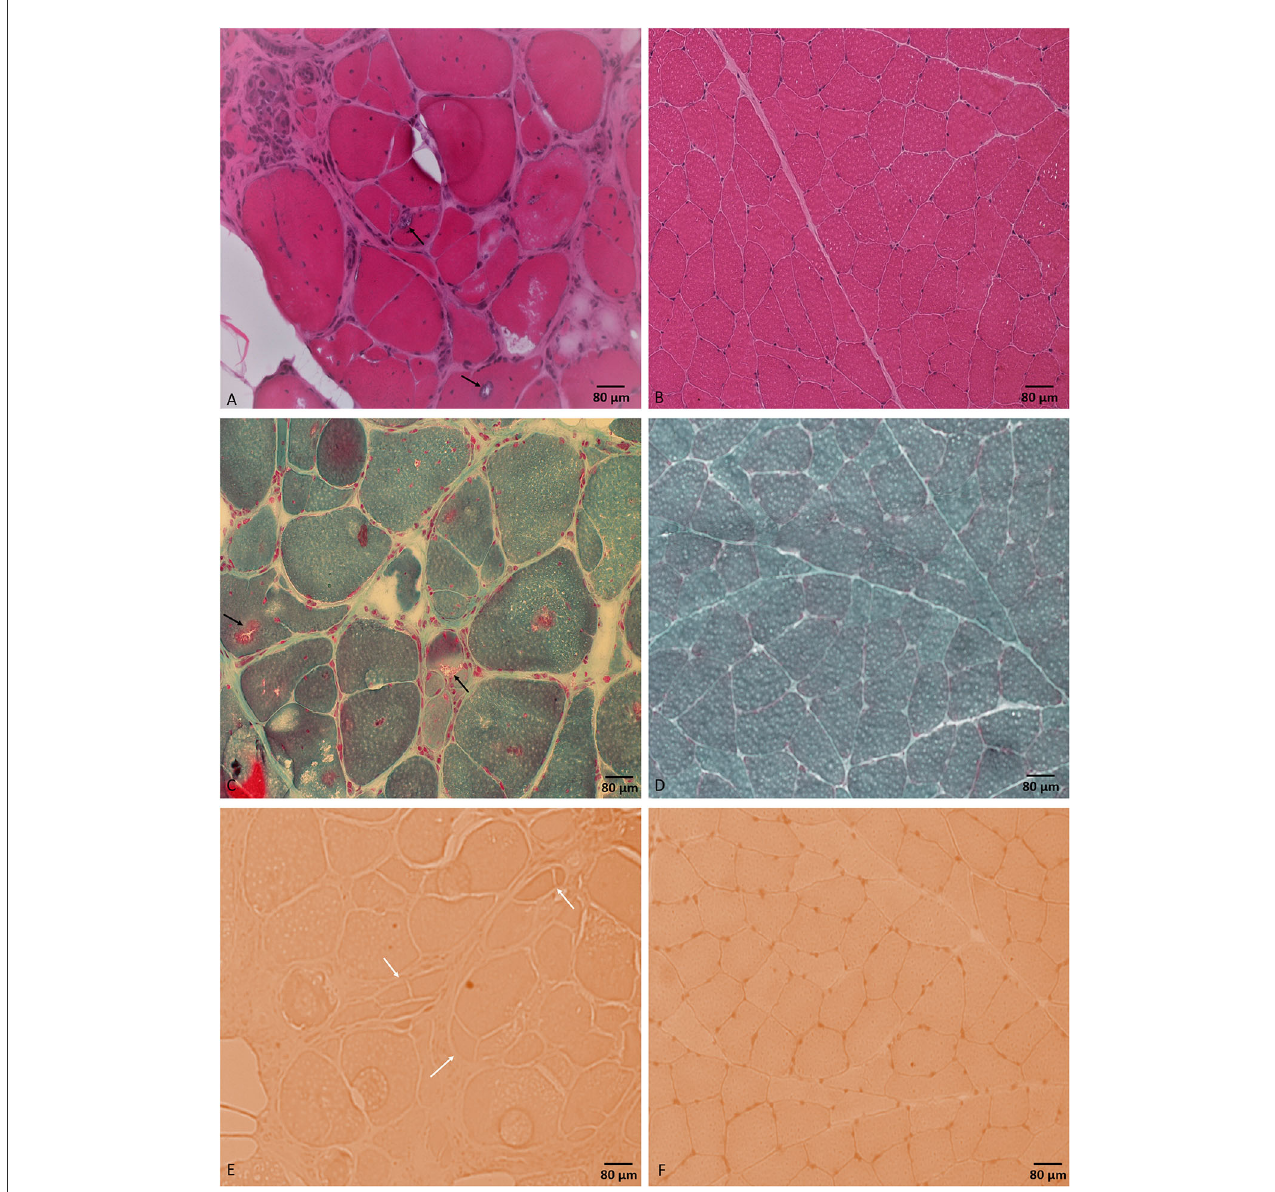
FIGURE2 Tibialis anterior muscle biopsy. H&E stained section (A) shows different myopathic features including marked variability in muscle fiber diameters and muscle fiber necrosis, regeneration, and splitting. Muscle fibers are harboring internalized nuclei and rimmed vacuoles (black arrows). Modified Gomori trichrome stained section (C) shows rimmed vacuoles (black arrows). Congo red stained section (E) shows prominent fiber splitting (white arrows). No inflammatory changes were noticed throughout the sample. (B, D, F) represent normal control muscle biopsy-stained sections by H&E, modified Gomori trichrome, and Congo red, respectively, processed at our laboratory. Bar = 80 µ